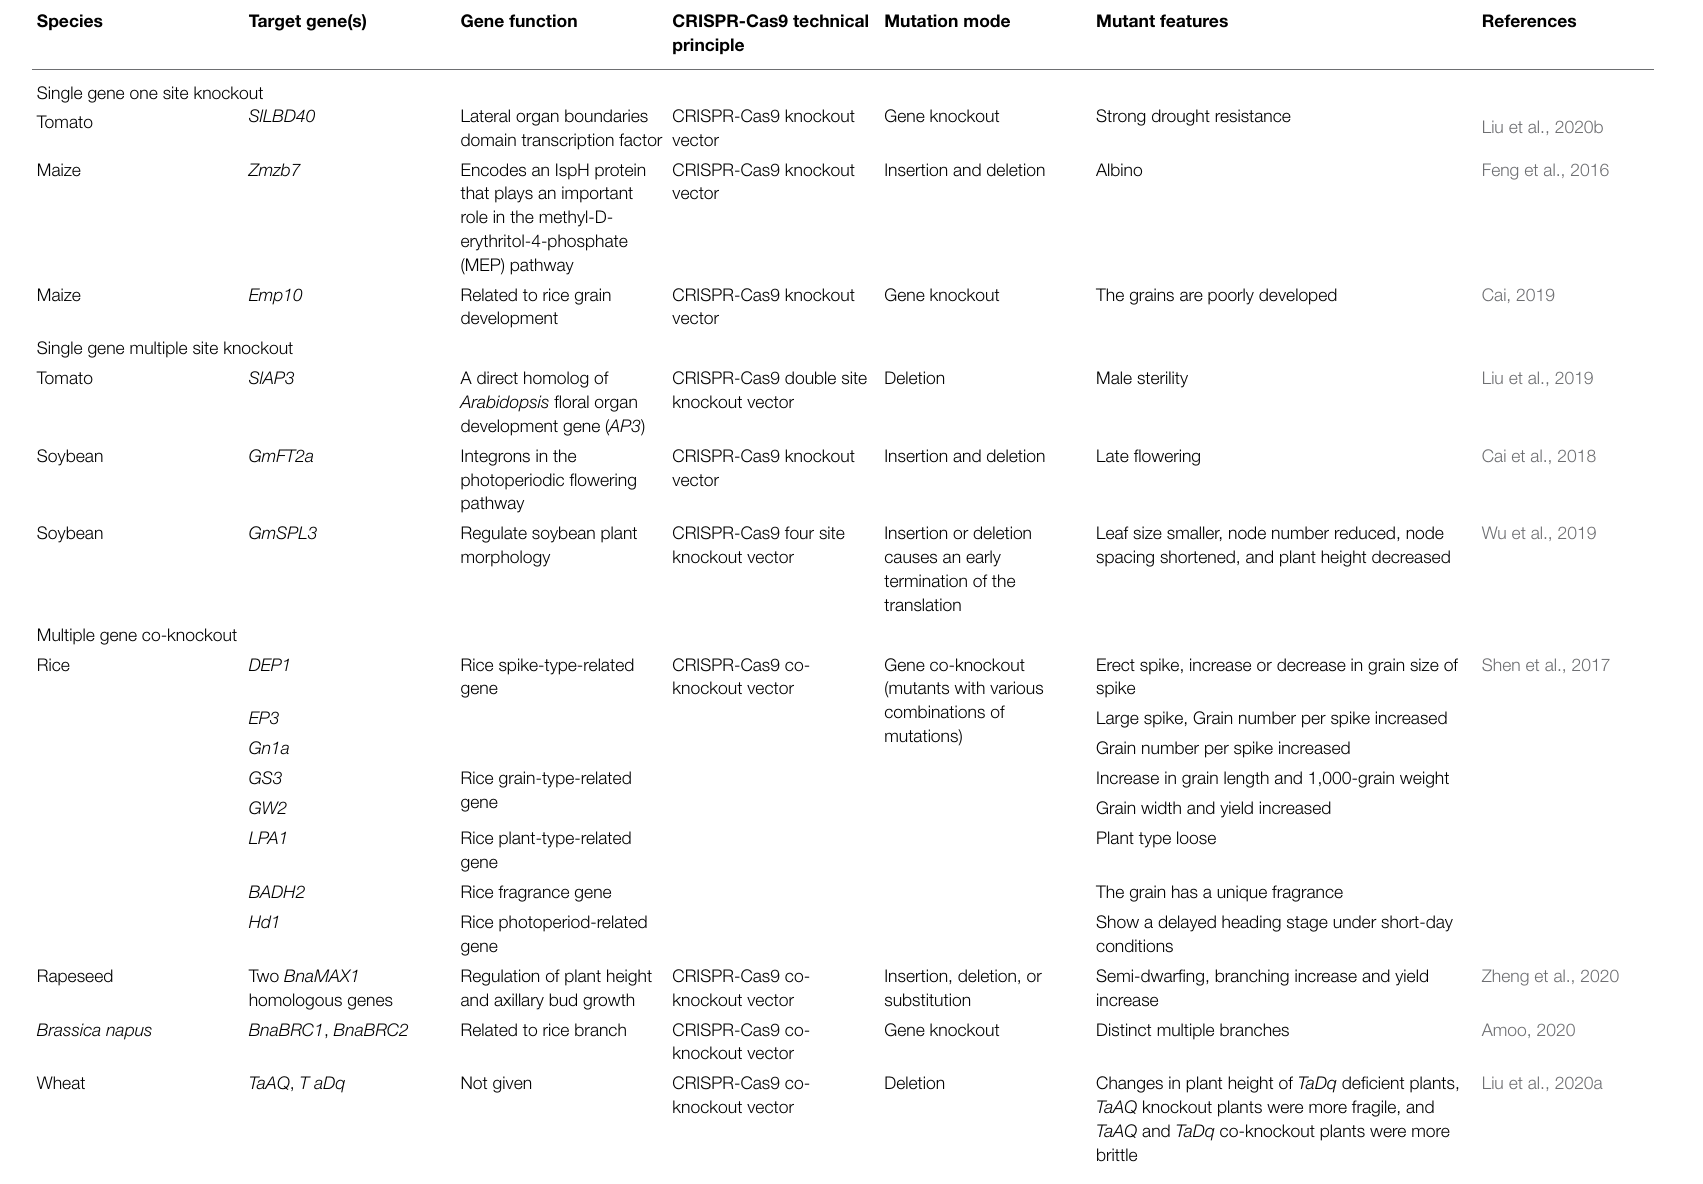
TABLE 1 | Clustered regularly interspaced short palindromic repeats (CRISPR)-Cas9